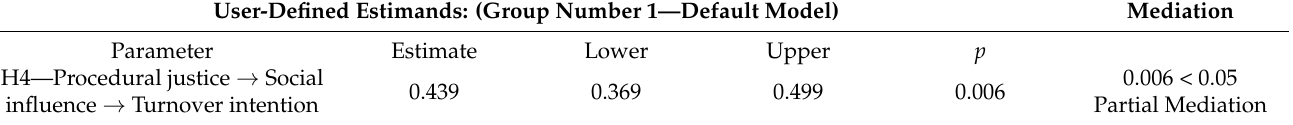
Table 4. Type of mediation (developed by